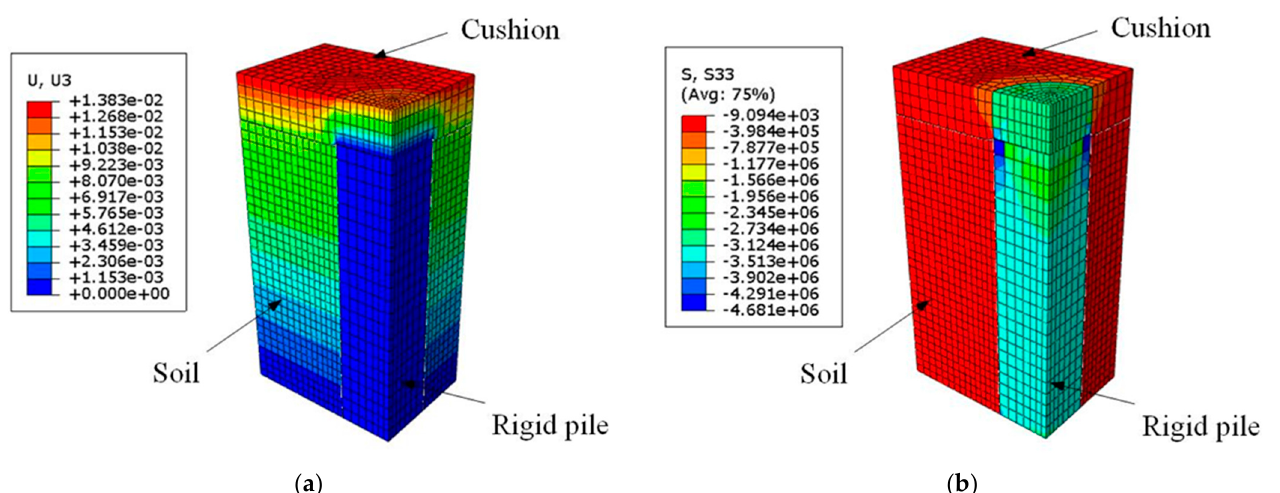
Figure 11. Finite element simulation results in test-1: ( a ) settlement contour (m); ( b ) stress contour (Pa).